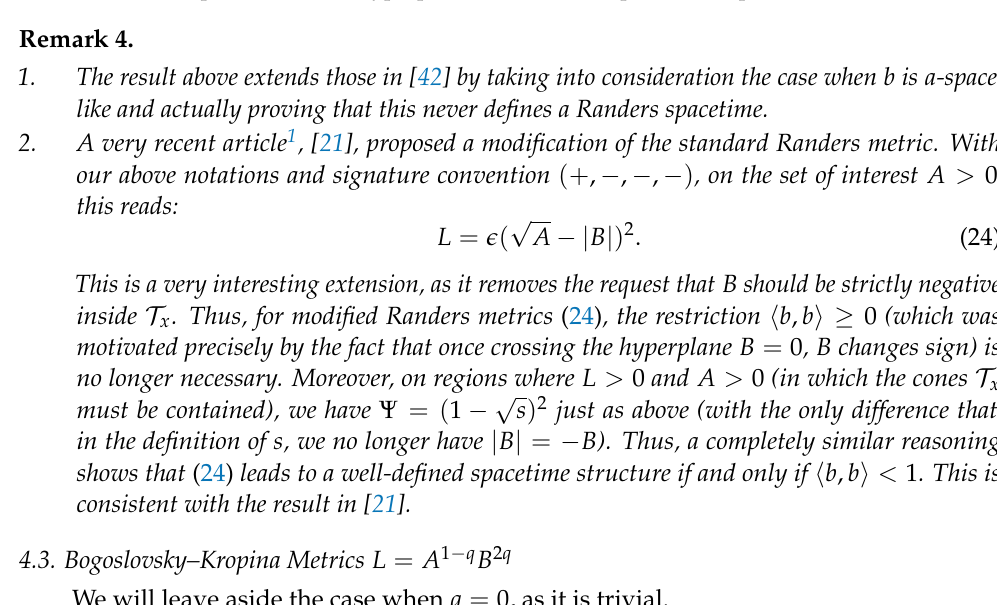
Figure 2. Possible positions of the hyperplane B = 0 with respect to the spacetime